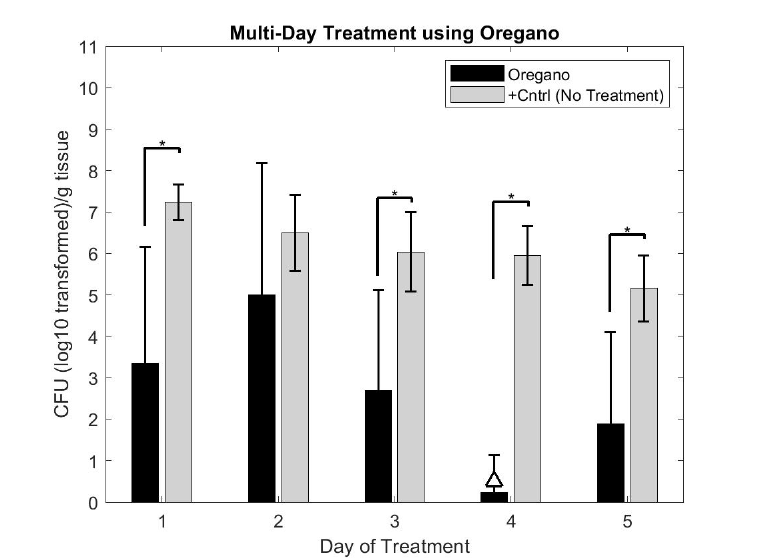
Figure 9. Graphical representation of biofilm burden on skin after multiple days of treatment with oregano gel in comparison to positive control samples, which received no treatment. The triangle ( (cid:52) ) indicates the treatment that attained a 4 log 10 reduction in CFU counts compared to that day’s positive control CFU count. Oregano gel only attained this level of reduction on Day 4. However, statistically significant results (student t -test compared to positive control, p < 0.05) were observed on all but one day of treatment. * Indicates p <